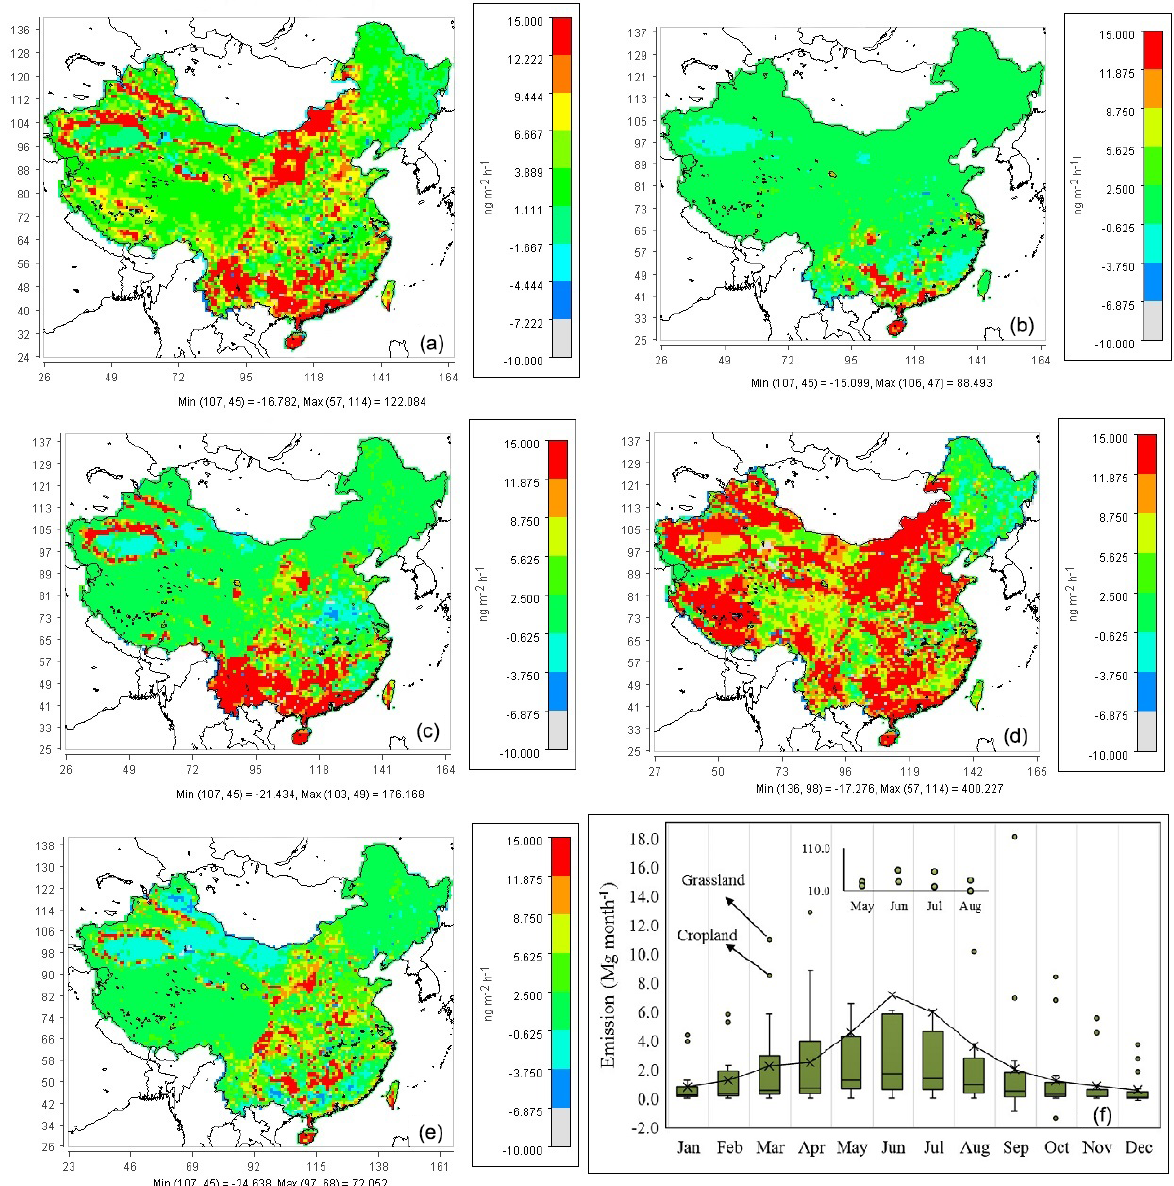
Figure 7. Model estimates of (a) annual mean Hg 0 fluxes in the model domain, (b) seasonal mean Hg 0 fluxes in winter, (c) seasonal mean Hg 0 fluxes in spring, (d) seasonal mean Hg 0 fluxes in summer, (e) seasonal mean Hg 0 fluxes in autumn, and (f) monthly Hg 0 fluxes in the grid cells (box and whisker chart showing maximum, 75th percentile, mean, median, 25th percentile, and minimum).